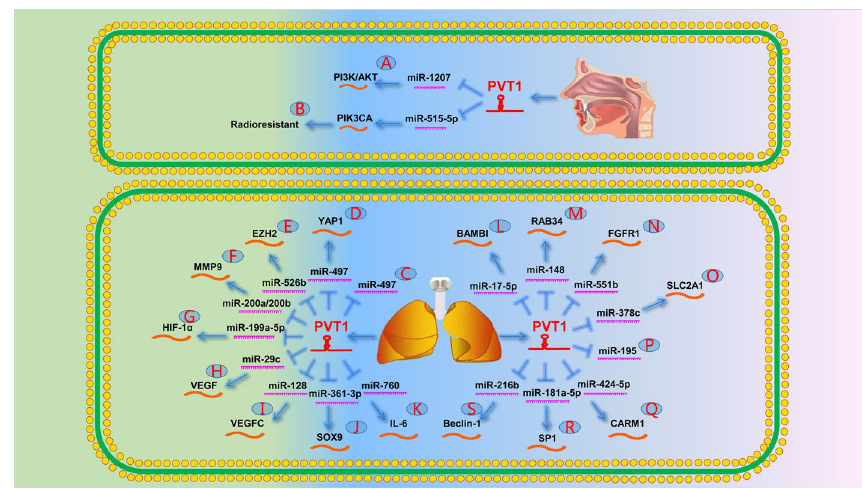
Fig. 1 The role of PVT1 in the respiratory system. A PVT1 promotes the expression of PI3K/AKT by targeting miR-1207. B PVT1 promotes the expression of PIK3CA by targeting miR-515-5p, which in turn causes radioresistance. C PVT1 directly targets miR-497. D PVT1 promotes the expression of YAP1 by targeting miR-497. E PVT1 promotes the expression of EZH2 by targeting miR-526b. F PVT1 promotes the expression of MMP9 by targeting miR-200a/200b. G PVT1 promotes the expression of HIF-1α by targeting miR-199a-5p. H PVT1 promotes the expression of VEGF by targeting miR-29c. I PVT1 promotes the expression of VEGFC by targeting miR-128. J PVT1 promotes the expression of SOX9 by targeting miR-361-3p. K PVT1 promotes the expression of IL-6 by targeting miR-760. L PVT1 promotes the expression of BAMBI by targeting miR-17-5p. M PVT1 promotes the expression of RAB34 by targeting miR-148. N PVT1 promotes the expression of FGFR1 by targeting miR-551b. O PVT1 promotes the expression of SLC2A1 by targeting miR-378c. P PVT1 directly targets miR-195. Q PVT1 promotes the expression of CARM1 by targeting miR-424-5p. R PVT1 promotes the expression of SP1 by targeting miR-181a-5p. S PVT1 promotes the expression of Beclin-1 by targeting